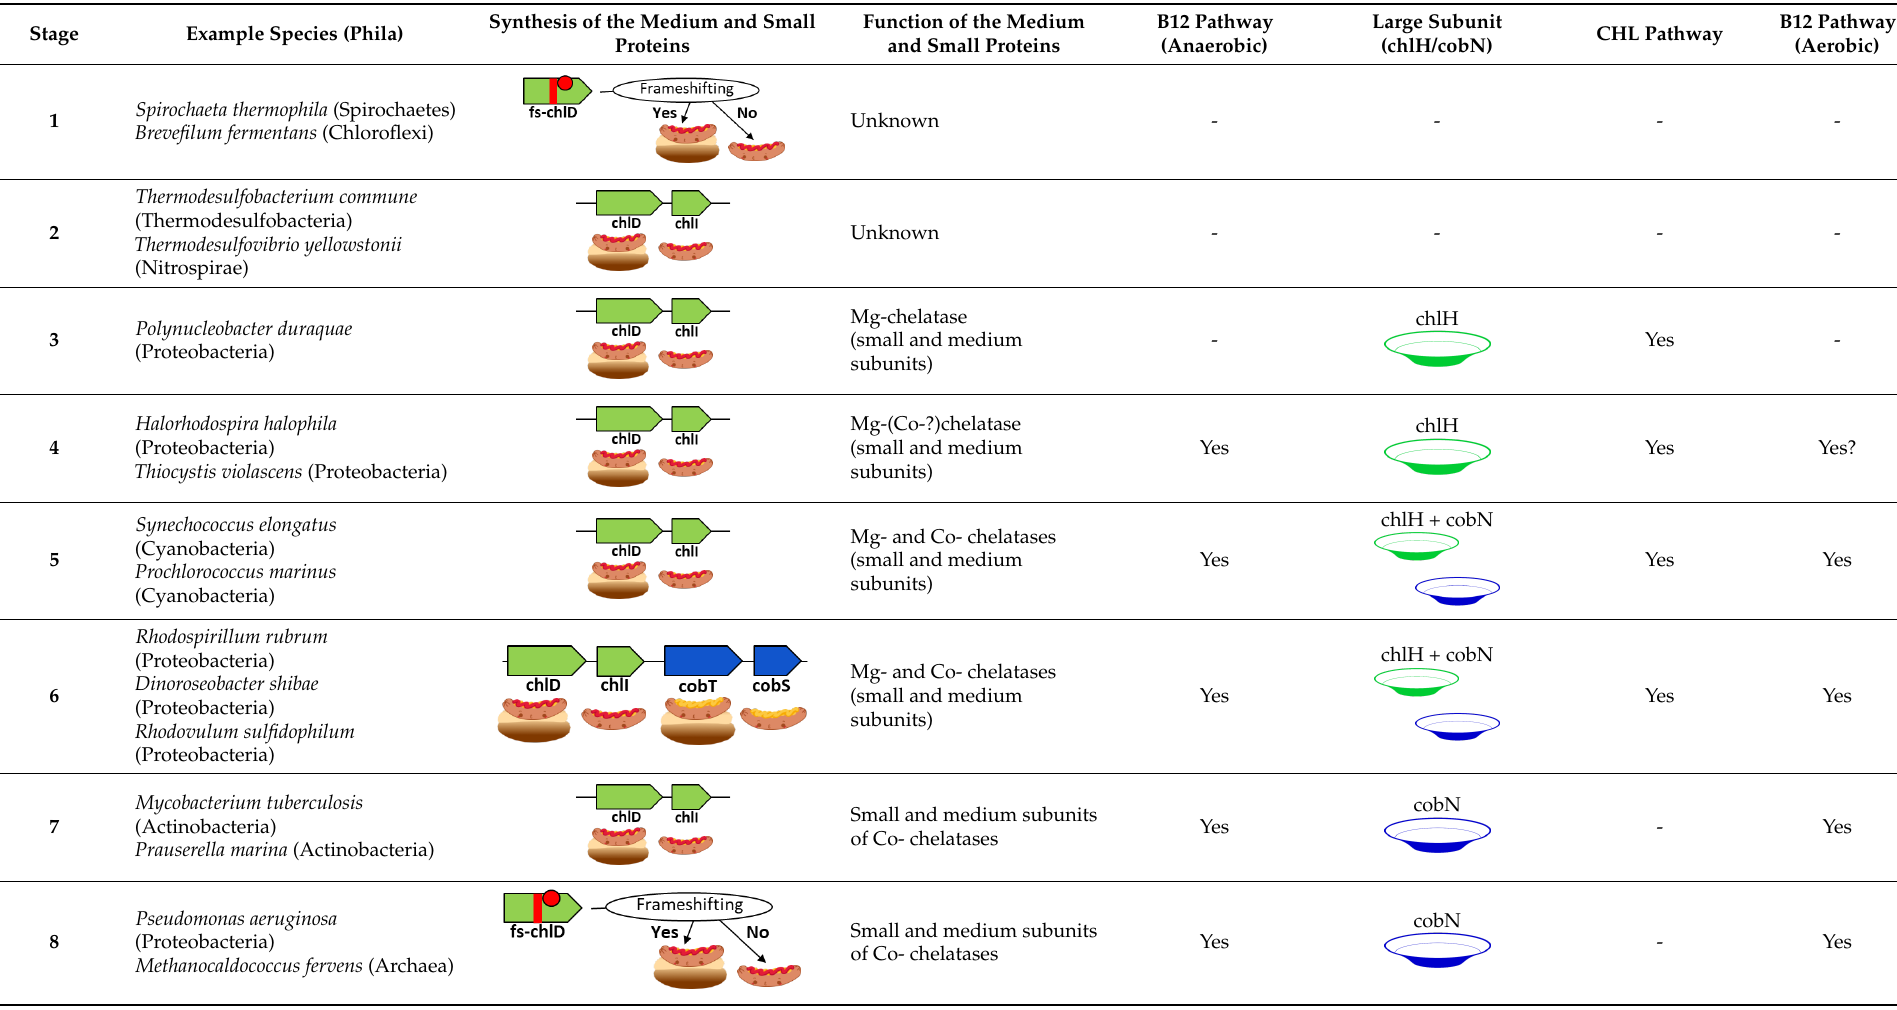
Table 1. The possible stages of the evolution of the genes encoding Mg-/Co-chelatases as well as CHL and B12